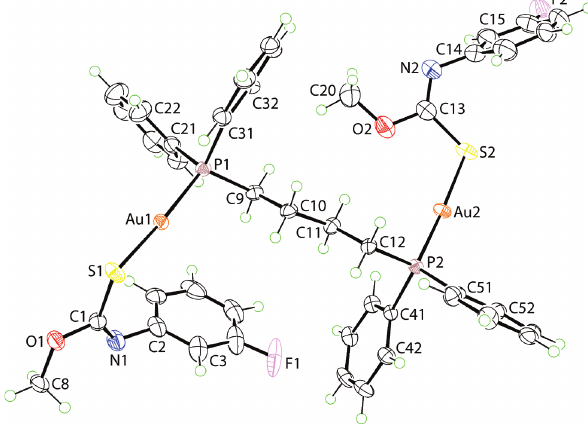
Table 2: Fractional atomic coordinates and isotropic or equivalent isotropic displacement parameters (Å 2